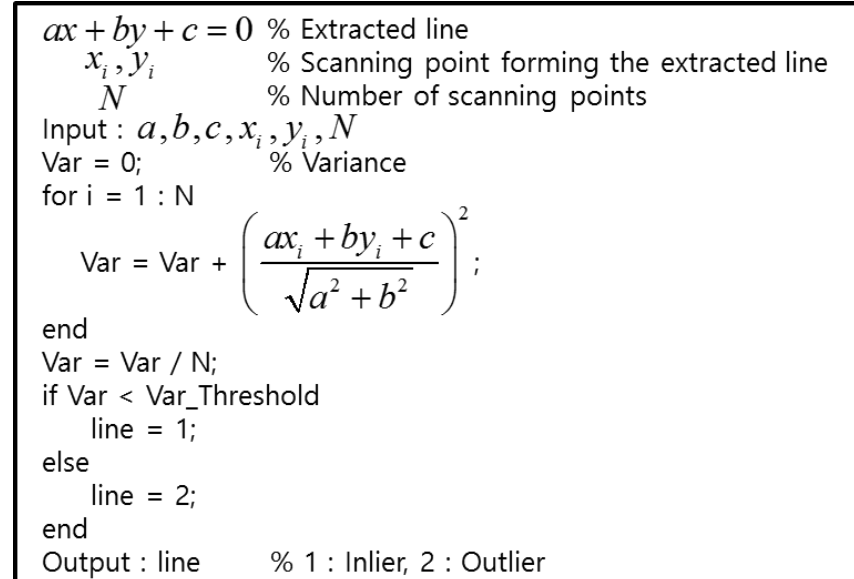
Figure 12. Light Detection and Ranging (LIDAR) points reflected by leaves of roadside trees and outer wall of building.